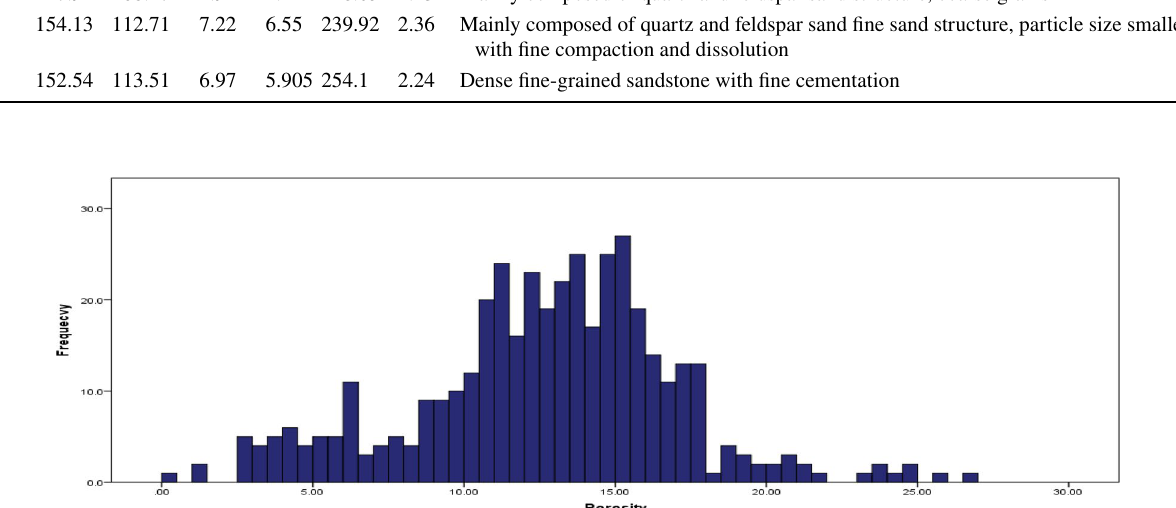
Fig. 1 Overall distribution of porosity